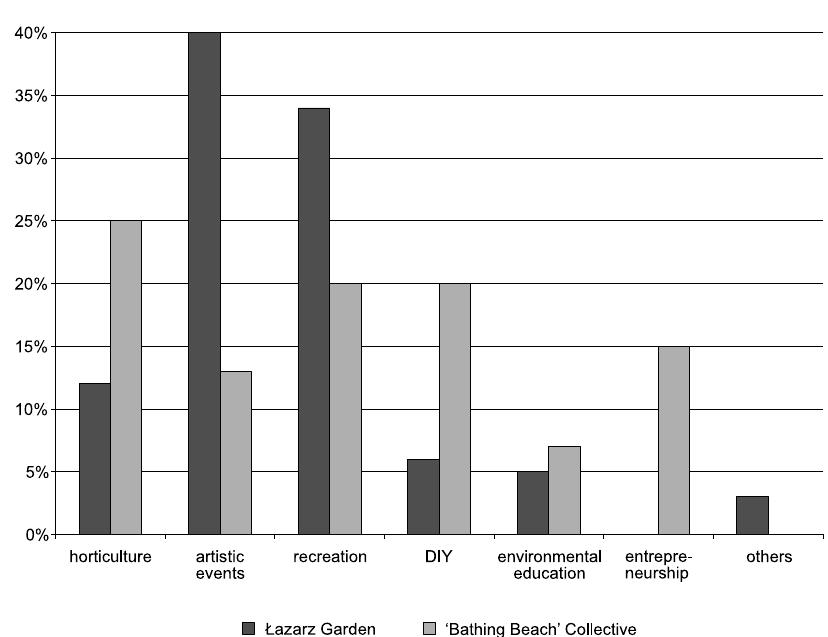
Fig. 8. Types of events held in community gardens in the district of Łazarz in the years 2014–2017. Source: own